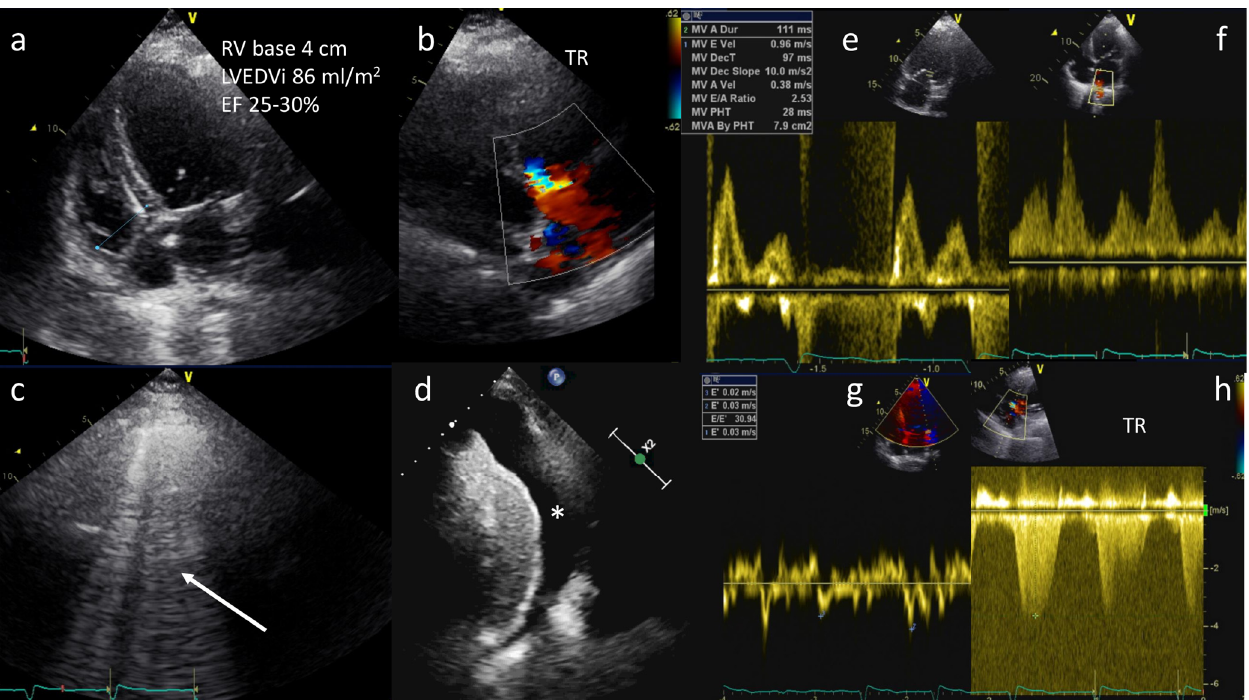
Figure 3. A 68-year-old female with history of dilated cardiomyopathy was admitted for shortness of breath, fatigue, and low-extremity edema. A diagnosis of acute pulmonary edema was made. TTE showed severe LV dilation (LVEDVi 86 mL/m 2 ), severe reduction in ejection fraction (EF 25– 30%), mildly dilated right ventricle (basal diameter 4 cm) ( a ), and moderate tricuspid regurgitation (TR) ( b ). Lung ultrasound showing B-lines in all sites explored (arrow) and pleural effusion (*) ( c , d ). Diastolic dysfunction with increased left ventricular end-diastolic pressures (LVEDP) and PAWP (E/A: 2.5, E/E’: 30 and S < D on pulmonary veins) ( e – g ) and estimated pulmonary artery pressure of 70 mmHg ( h ).